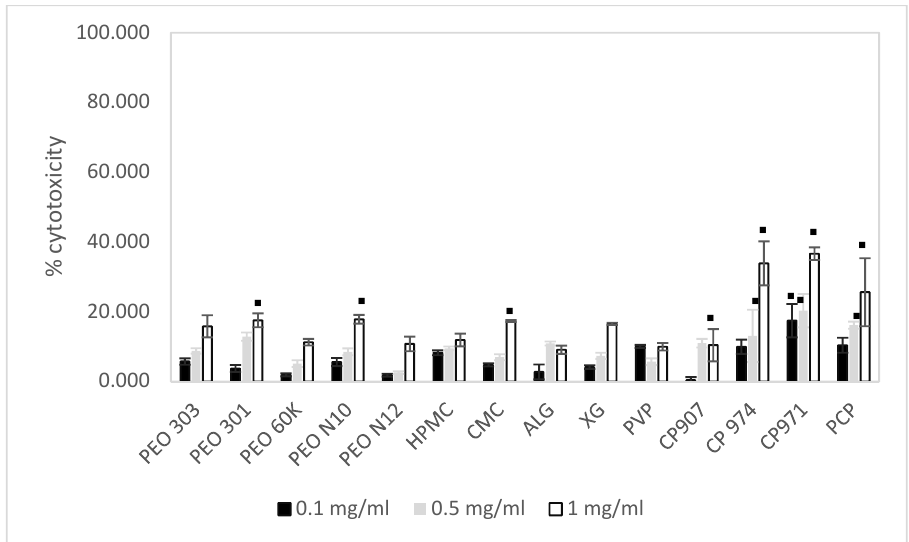
Figure 5. Cytotoxicity of polymer solutions on MAC-T cells after 72 h incubation as detected by the LDH assay (mean ± SD, n = 3). Black (0.1 mg/mL), grey (0.5 mg/mL) and white (1 mg/mL) bars depict the concentration of each polymer. The standard deviation is shown by the error bars. ▪ denotes significance from negative control.